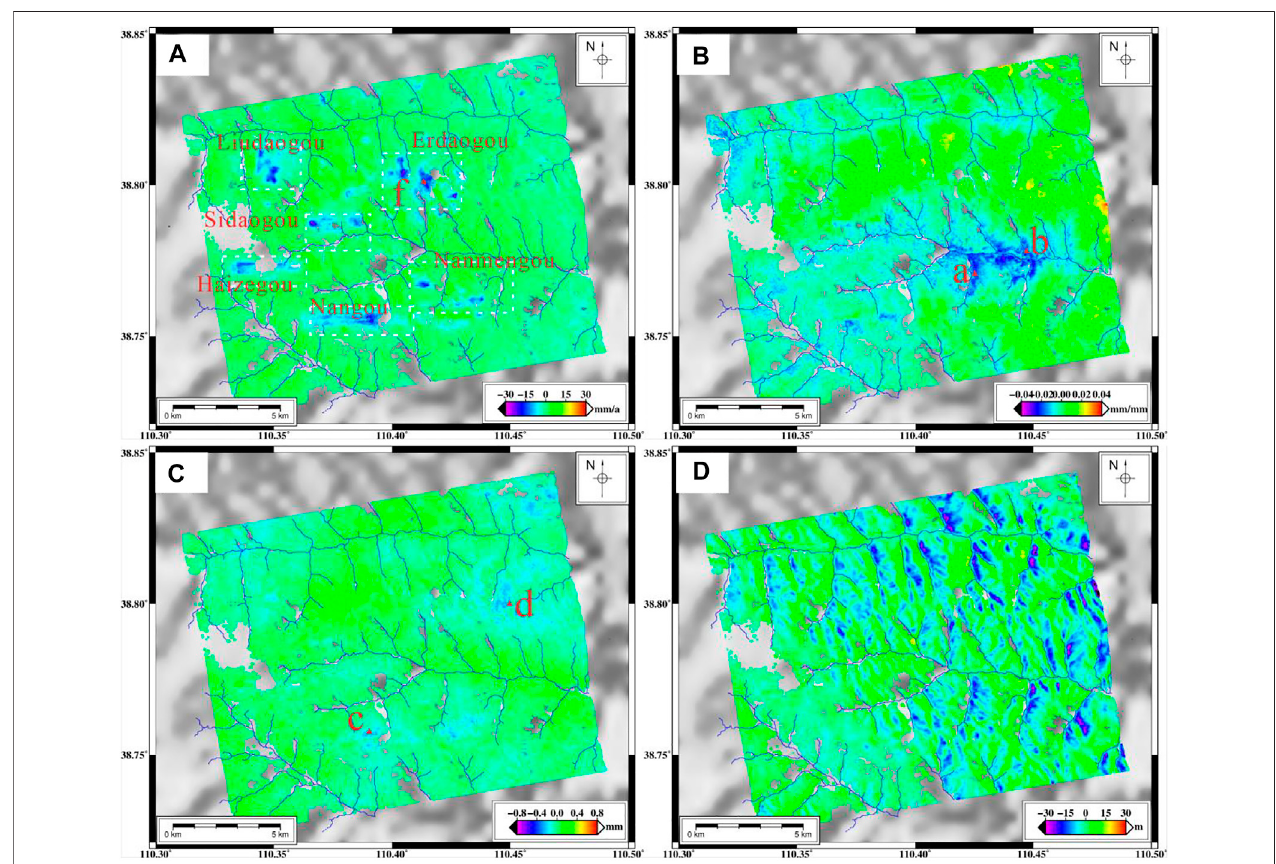
FIGURE 4 | Estimated coef fi cients of the improved deformation model in Eq. 4 and DEM errors over the coherent areas. (A) v ; (B) a 1; (C) a 2; (D) DEM errors Δ h. The white dashed box represents the area with severe soil and water deformation, and the place name of the area marked with red word. Points a, b, c, d, and f represents the selected feature